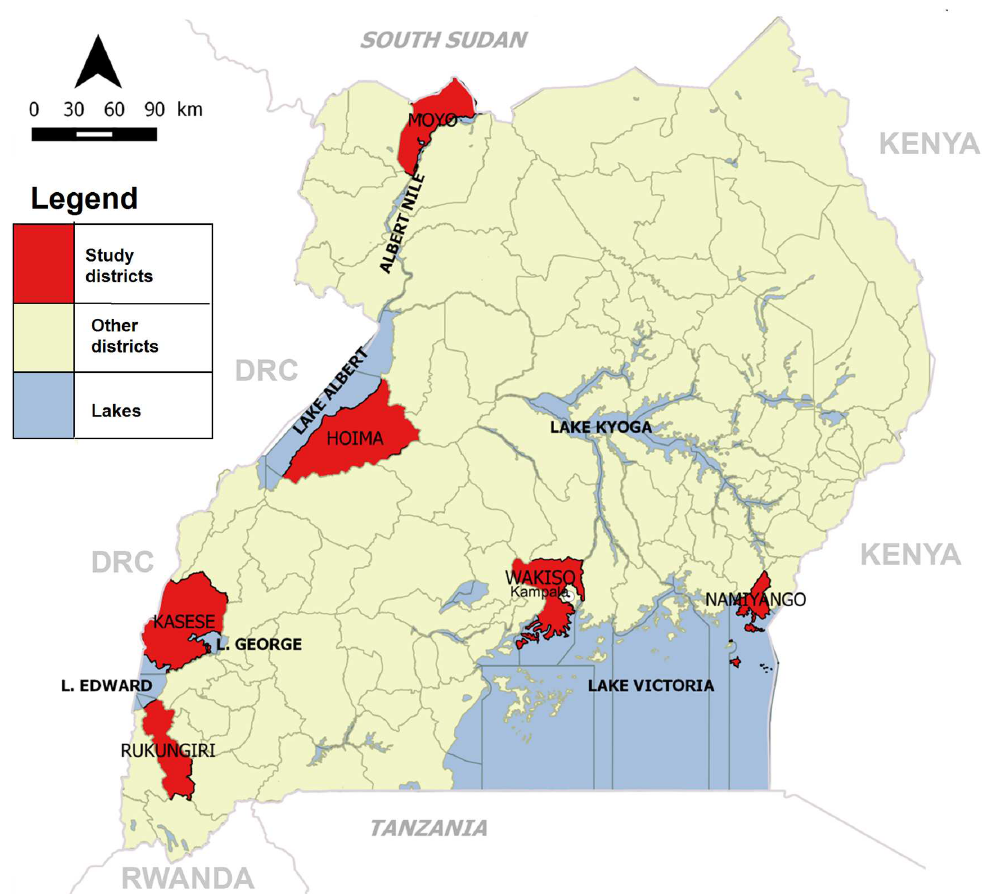
Fig 1. Location of the study districts, major lakes and rivers in Uganda,